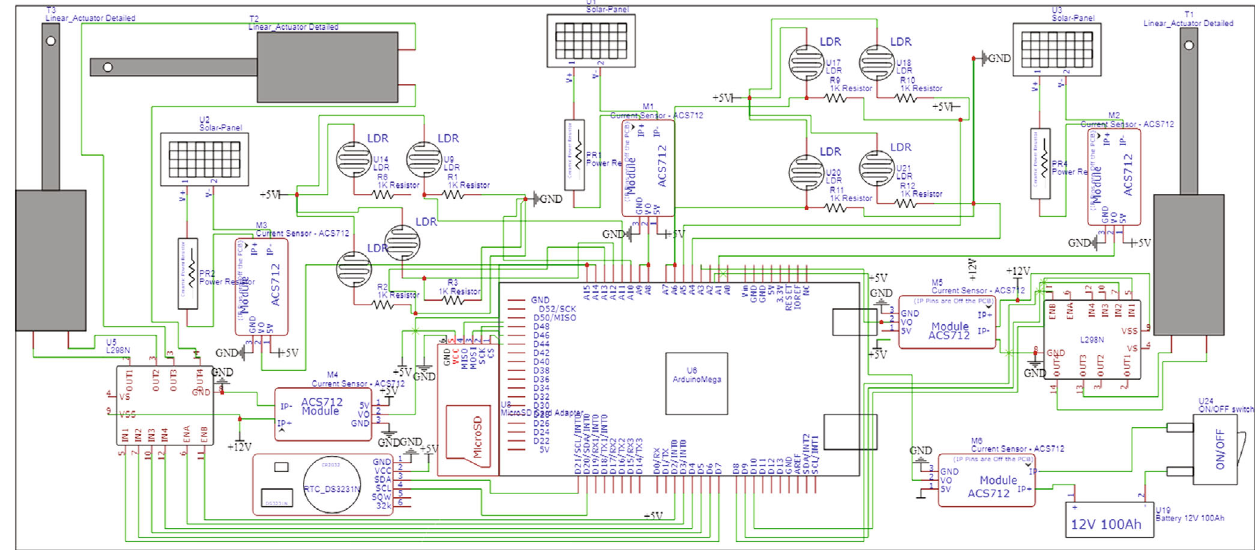
Figure 2: The electrical schematic diagram for the FTPV, SAST, and